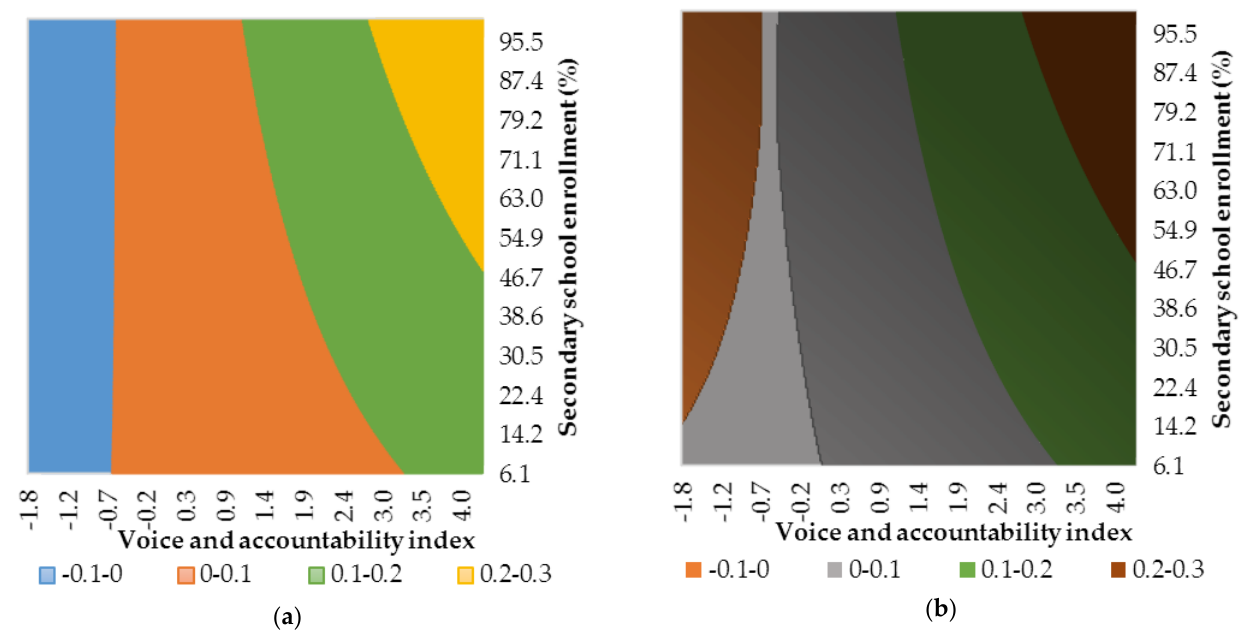
Figure A6. Conditional effect of financialisation on growth based on Est. 6 in Table A2. ( a ) Estimated conditional slope coefficient over the whole range of observed values for institutional quality and development level. ( b ) Estimated statistically significant conditional slope coefficient. Light gray represents a combination of institutional quality and development level for which effect of financialisation on growth is statistically insignificant. Source: authors’ contributions.